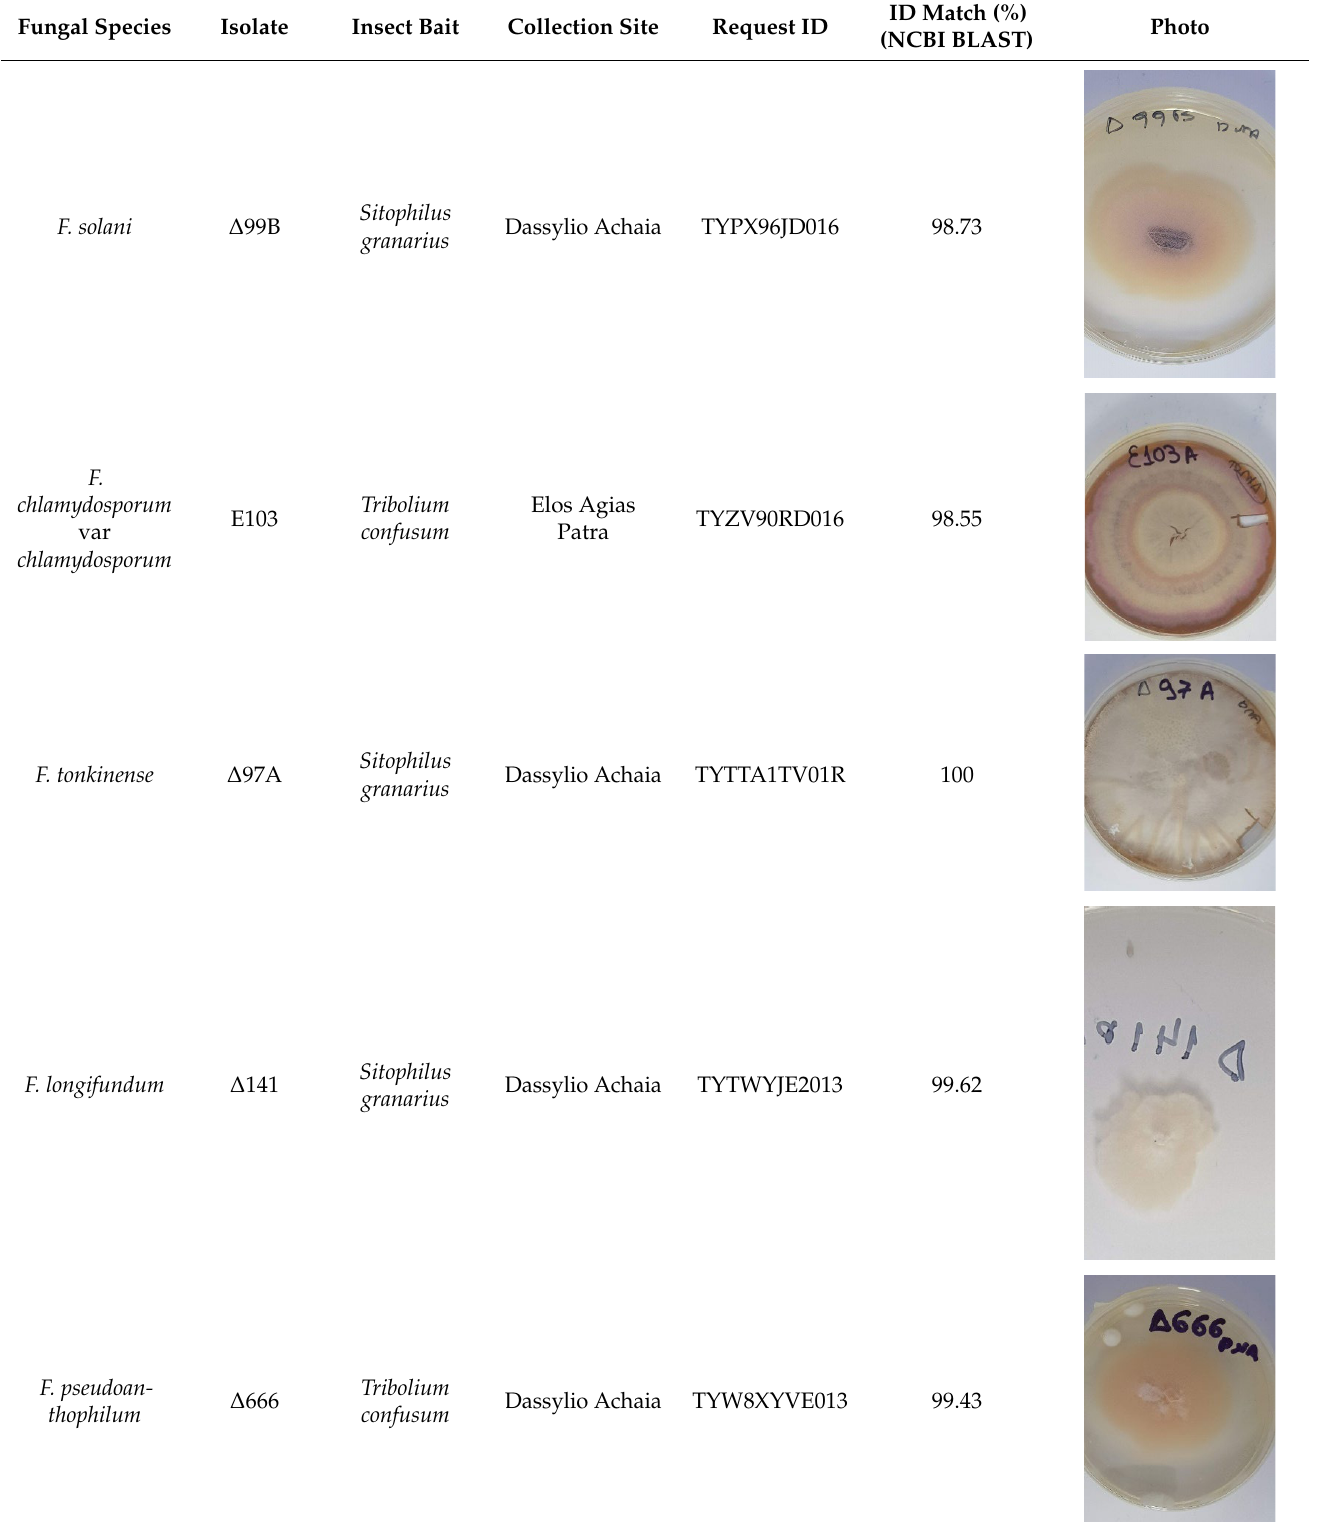
Table 2. Isolates of Fusarium species that were tested in the present study. All collected fungal isolates Table 2 . Isolates of Fusarium species that were tested in the present study. All collected fungal iso- Table 2 . Isolates of Fusarium species that were tested in the present study. All collected fungal iso- were lab cultured and stored at 25 ◦ C in SDA plates. Table 2 . Isolates of Fusarium species that were tested in the present study. All collected fungal iso- Table 2 . Isolates of Fusarium species that were tested in the present study. All collected fungal iso- lates were lab cultured and stored at 25 °C in SDA plates. lates were lab cultured and stored at 25 °C in SDA plates. lates were lab cultured and stored at 25 °C in SDA